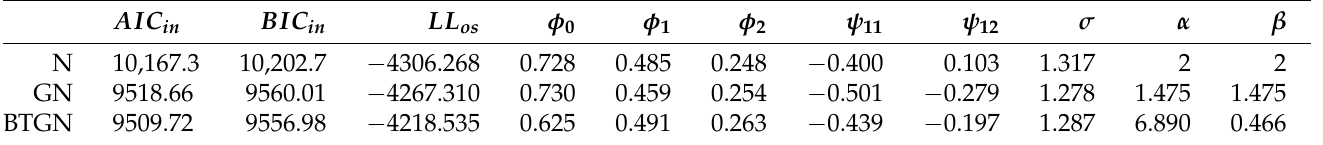
Table 4. Fitted S ( 1/24 ) · AR ( 2 ) models with in-sample criterion and out-of-sample LL. AIC